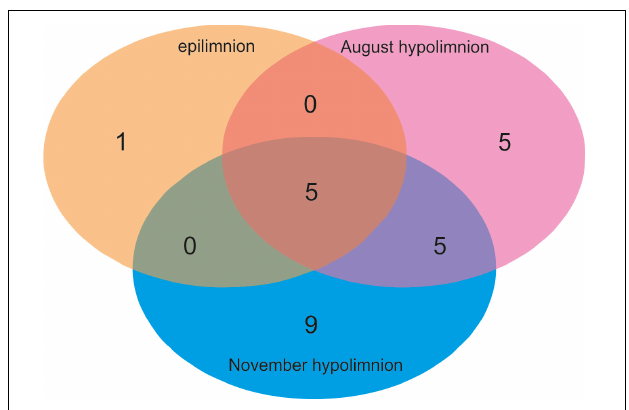
FIGURE 5 | Venn diagram showing the OTU sharing of kinetoplastid flagellates among the epilimnion and hypolimnion of Lake